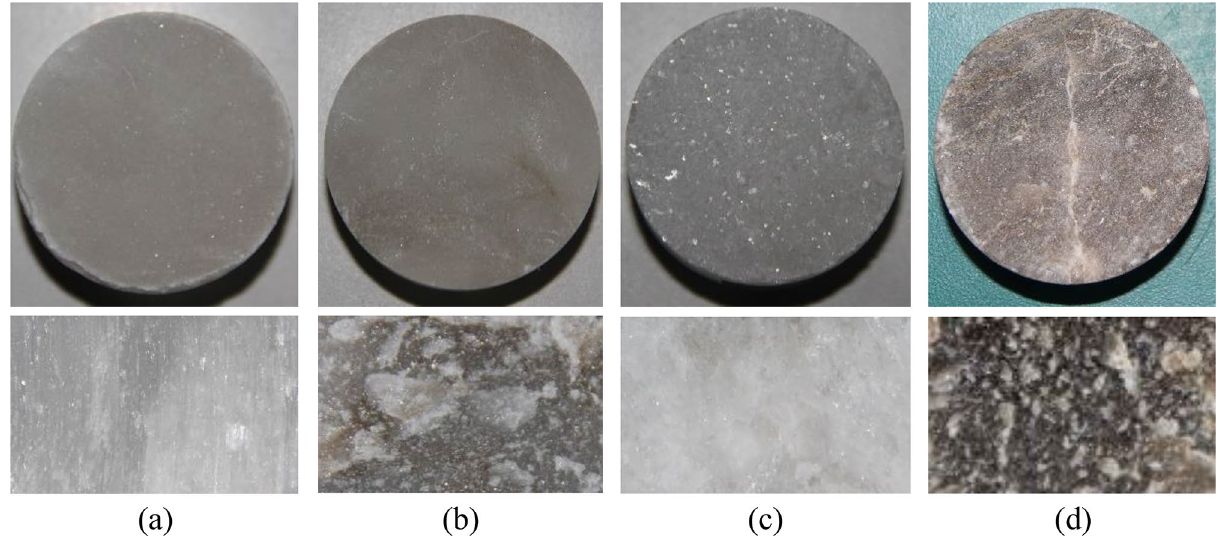
Figure 2. Surface and interior characteristics of the four types of gypsum rock samples: ( a ) fiber gypsum with transparent features and longitudinal fibrous structures, ( b ) transparent gypsum with local dark features and white flaky structures, ( c ) alabaster with white transparent features and transparent granules, ( d ) ordinary gypsum with whole dark features and local white flaky structures. (The Figure contains the pictures of four kinds of gypsum rock obtained by camera, and is not generated by other